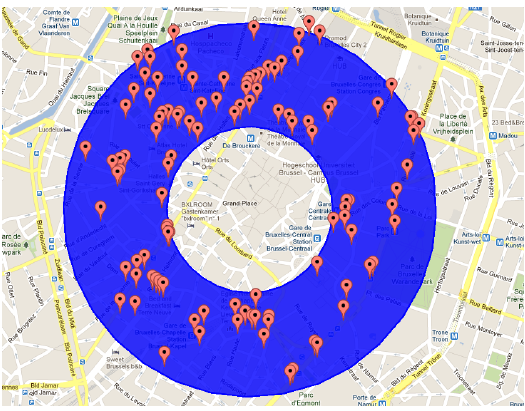
Figure 9. Places between 400 and 900 meters from Brussels’ Grand Place.